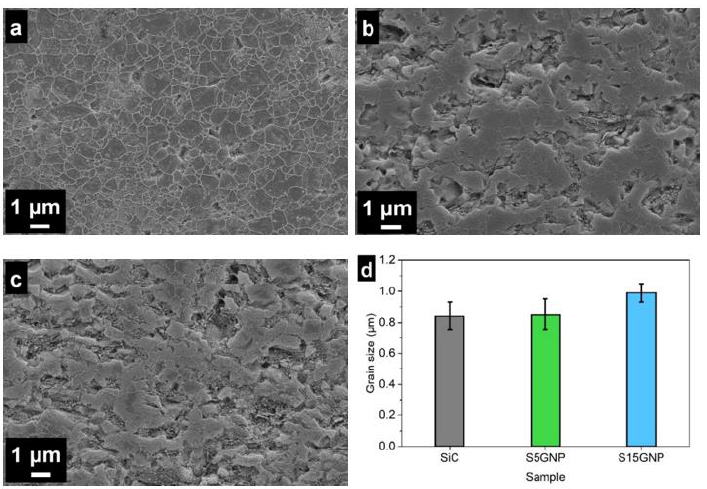
Figure 2. Plasma etched surfaces of individual layers in 3-layered composites sintered under 50 MPa pressure (C3-50) and grain size distribution of SiC. ( a ) 0% GNPs, ( b ) 5% GNPs, ( c ) 15% GNPs, ( d ) grain size of individual layers.